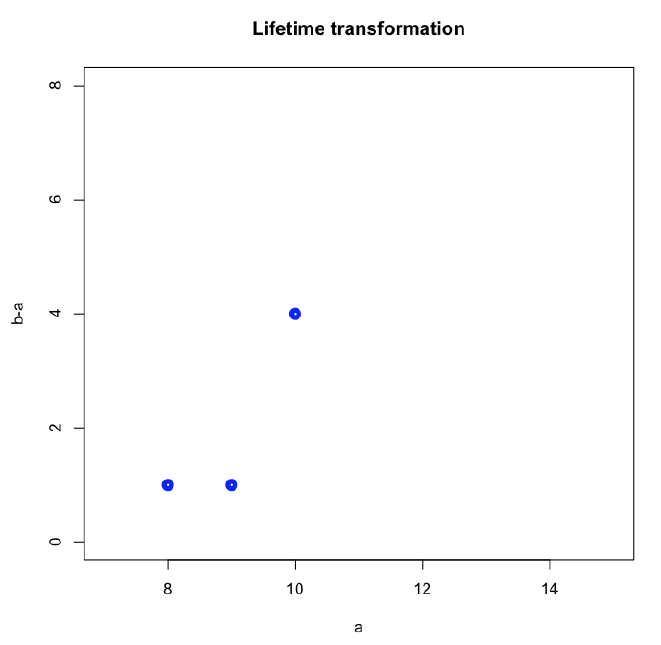
Figure 9. Life-time diagram for the map f X when X = ( 11,14,9,7,9,7,8,10,9 )